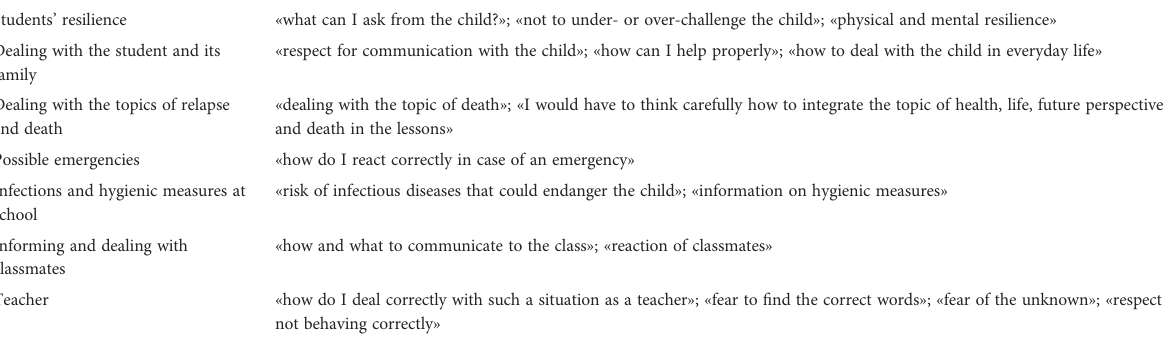
TABLE 3 Fears and concerns mentioned by the teachers, sorted in seven thematical groups (examples